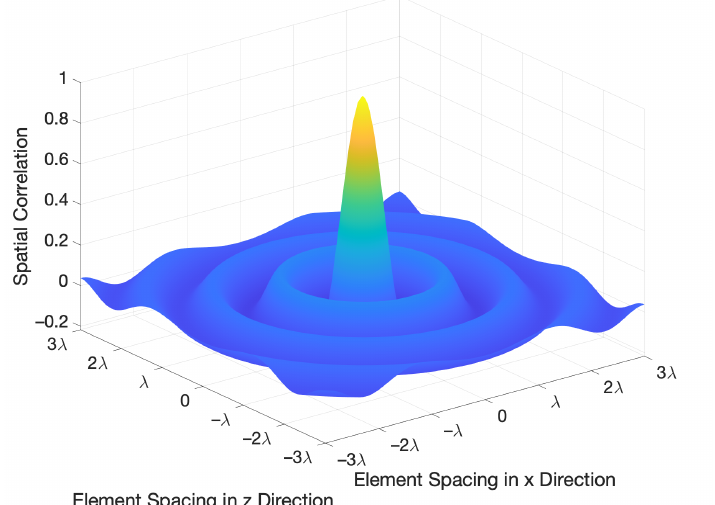
Figure 2. Spatial correlation among the holographic RIS elements under isotropic scattering, where λ denotes the carrier wavelength. Note that the element spacing in x and z directions are expressed in terms of the wavelength λ , which is directly labeled on the abscissa and ordinate, while the spatial correlation is dimensionless.